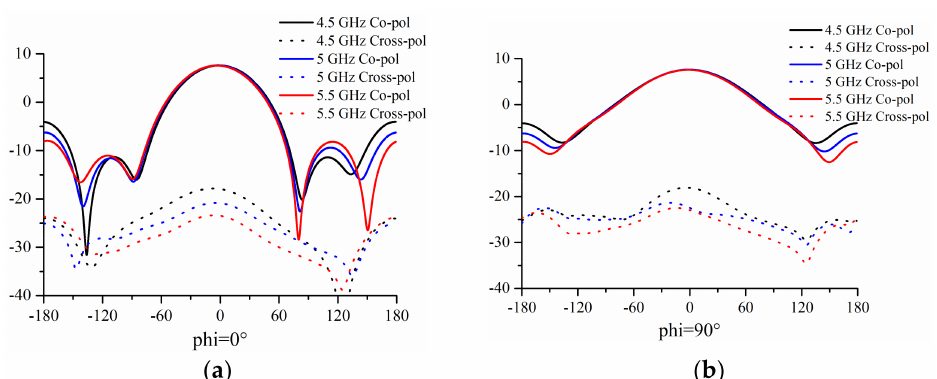
Figure 7. Measured radiation efficiencies and gains.